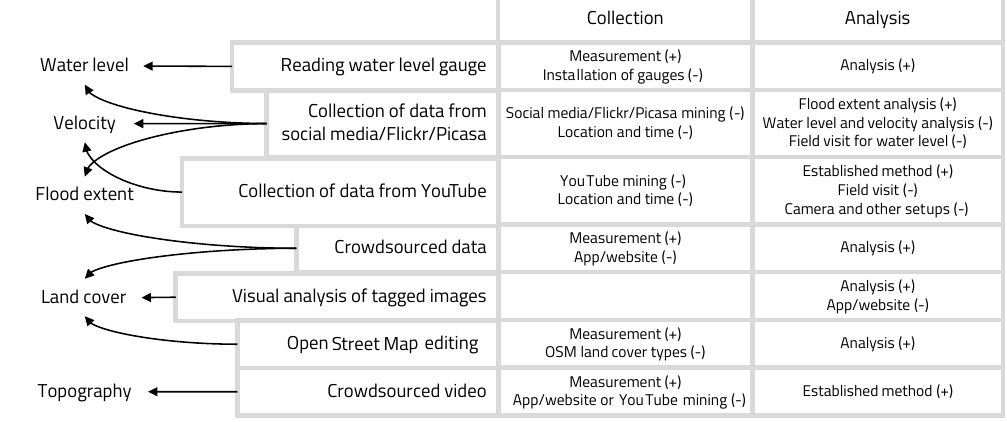
data obtained by reading a water level gauge is easy to